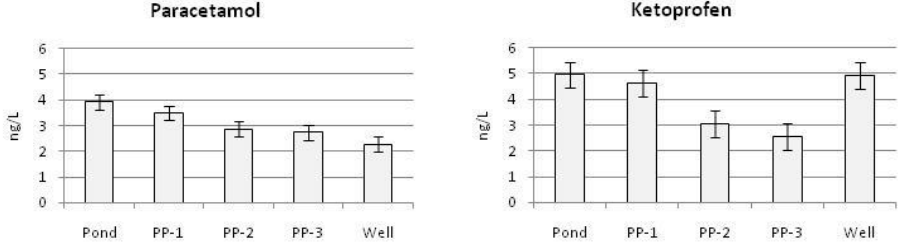
Figure 5. Annual average concentrations of paracetamol and ketoprofen throughout the infiltration route in subsequent measurement series.